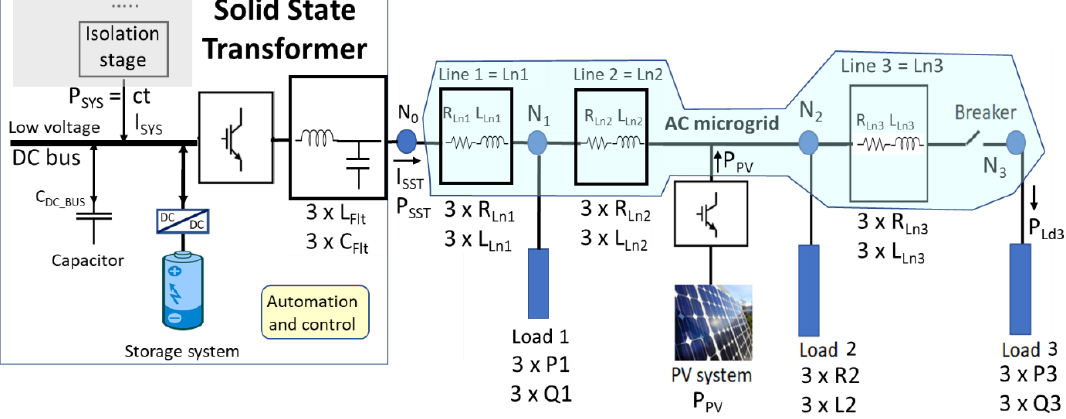
Figure 7. The one-line diagram of the SST interfaced microgrid.